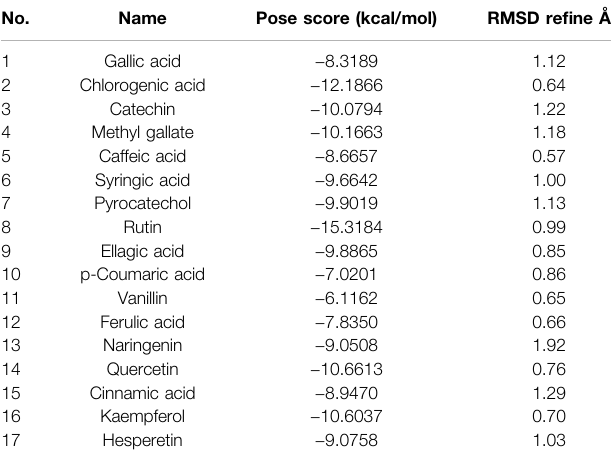
TABLE 5 | Pose score results of detected compound interactions with myeloperoxidase antioxidant target proteins. No.